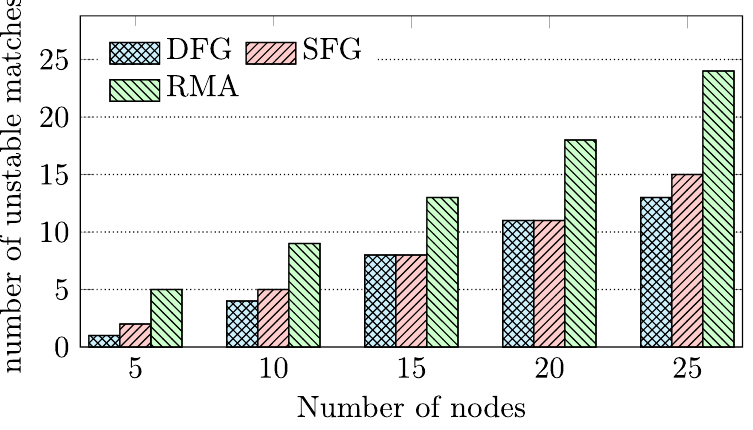
Figure 5. Number of unstable matches of DFG, SFG, and RMA.